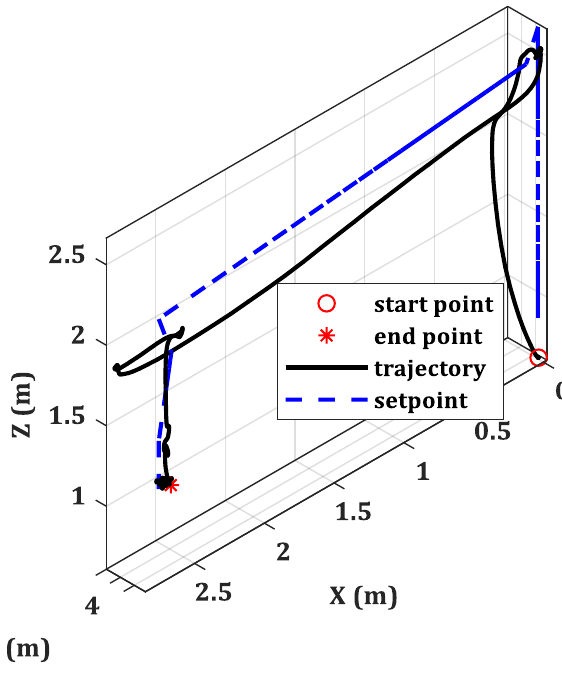
Figure 14. Yaw angle of the UAV during one of the trials.